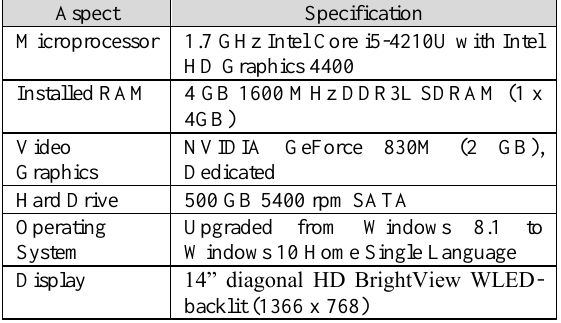
Table 1. Specifications of workstation